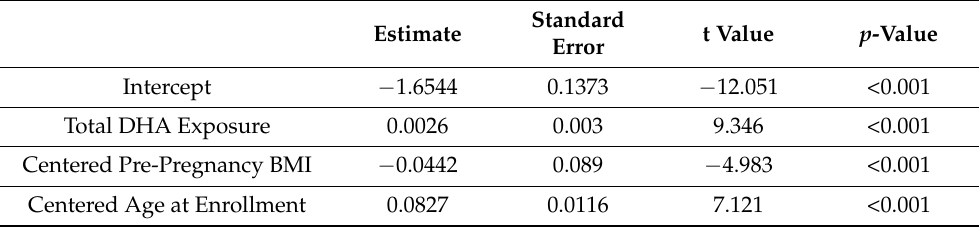
Table 2. Regression of d = RBCDHA M − RBCDHA CB vs. DHA exposure (mg/d) with cen- tered BMI and centered age as covariates, where RBCDHA M = maternal DHA at delivery and RBCDHA CB = cord blood DHA at delivery.